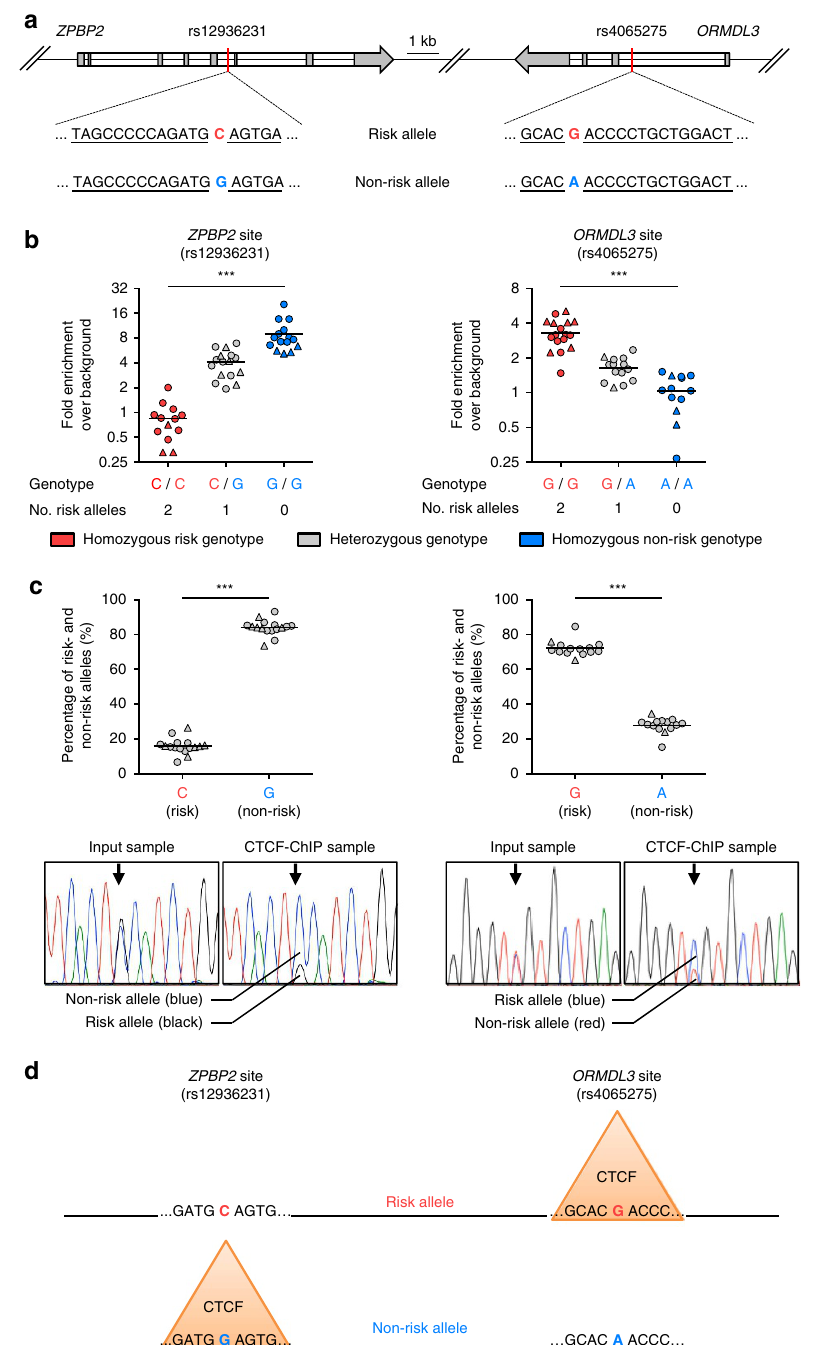
Figure 4 | CTCF-binding sites are switched by 17q21 SNPs. ( a ) Schematic representation of the 17q21 locus containing CTCF-binding motifs (underlined sequence) that overlap with the linked SNPs rs12936231 (C/G; ZPBP2 site) and rs4065275 (G/A; ORMDL3 site); the asthma-risk SNP is indicated in red, the non-risk SNP in blue. ( b ) Real-time PCR quantification of DNA sequences, containing the 17q21 linked SNPs rs12936231 ( ZPBP2 site) or rs4065275 ( ORMDL3 site), after anti-CTCF ChIP of chromatin extracts obtained from polarized T H 1, T H 2 cells (shown as circles) and primary CD8 þ Tcells (shown as triangles; see Methods) of donors categorized based on allelic status of SNP overlapping the respective CTCF motif (as shown in a ). Data are expressed as fold enrichment relative to an irrelevant background control; data were obtained from four independent experiments and each dot represents data from a single ChIP assay; n ¼ 44 assays from 15 subjects (see Methods and Supplementary Fig. 4c,d). ( c ) Percentage of DNA sequences containing the risk and non-risk SNPs at rs12936231 ( ZPBP2 site) or rs4065275 ( ORMDL3 site) following Sanger sequencing of DNA obtained following anti-CTCF ChIP assay performed in heterozygous donors shown in b (see Methods and Supplementary Fig. 4b); shown below are nucleotide traces from Sanger sequencing of ChIP and input DNA from a representative experiment. ( d ) Schematic representation of the switch in CTCF binding introduced by the linked asthma-risk SNPs (rs12936231 and rs4065275) in the 17q21 locus; orange triangles represent binding of CTCF to the preferred allele. *** P o 0.001 by Mann–Whitney U